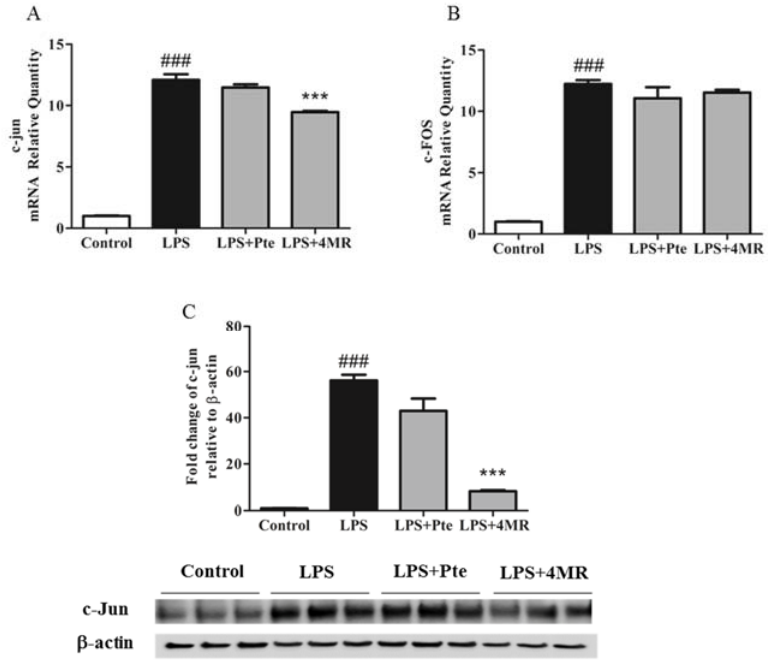
Figure 6. Effect of Pte and 4MR on LPS-induced c-Jun and c-Fos mRNA expression and c-Jun protein expression in RAW264.7 cells. ( A , B ) Cells were cotreated with both LPS (0.1 µ g/mL) and Pte (5 µ M) or 4MR (5 µ M) for 45 min. The mRNA expression levels were evaluated by qRT-PCR and normalized to the 18S levels. ( C ) The protein expression levels were measured by Western blot (c-Jun/b-actin). The data were representatives of three independent experiments and presented as the mean ± SEM. ### p < 0.001 compared to control; *** p < 0.001 compared to LPS